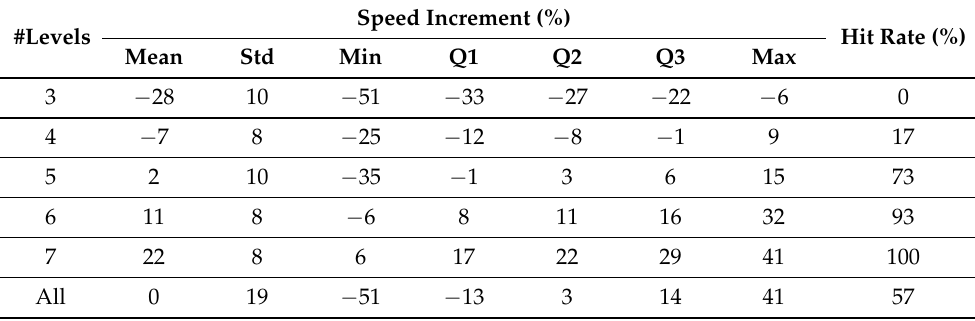
Table 2. Speed increment of CARRY-MAP with respect to VIV-MAP in speed optimization.